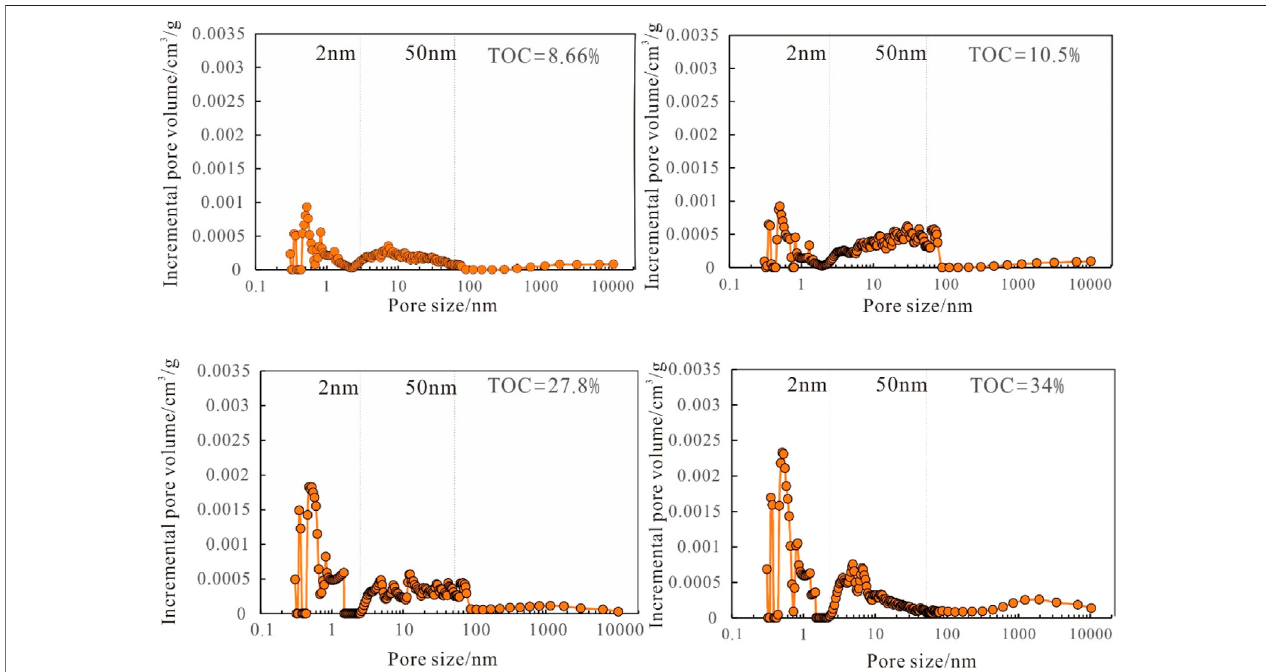
FIGURE 3 | Pore size distribution of typical shale samples of Shan 23